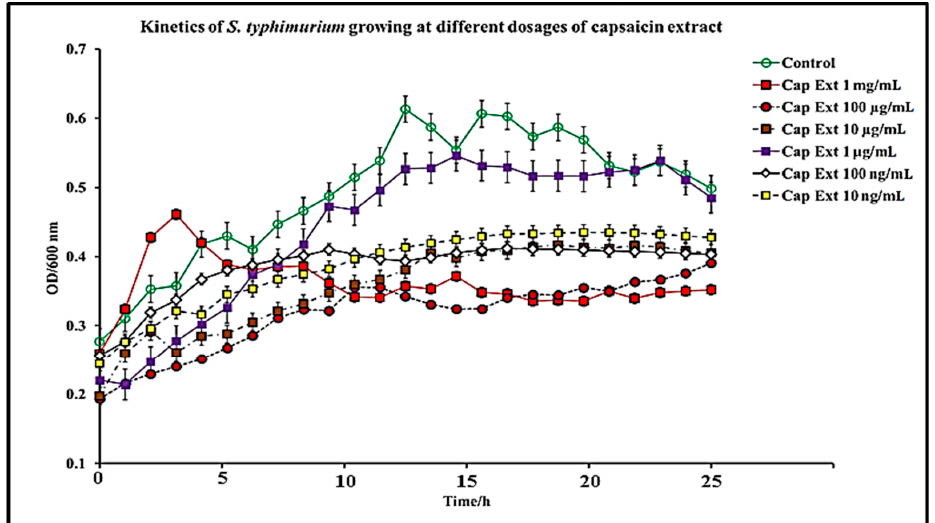
Figure 1. Kinetic dose and time-dependent effect of capsaicin extract on S. typhimurium growth in vitro. The data are represented as means of three independent experiments ± standard deviation.